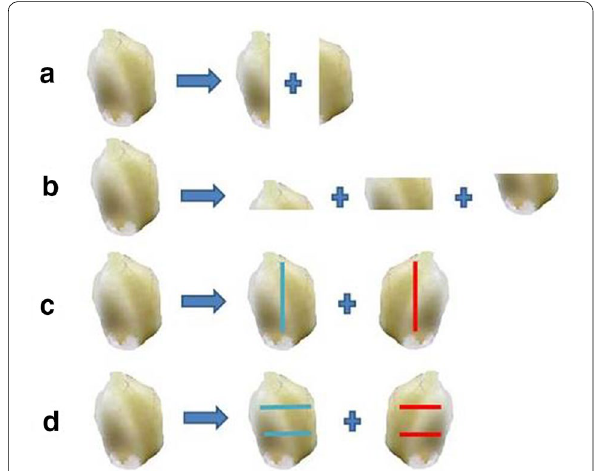
Fig. 1 F. cirrhosa : Four different sections/incisions a : longitudinal section; b : transverse section; c : longitudinal incision; d :